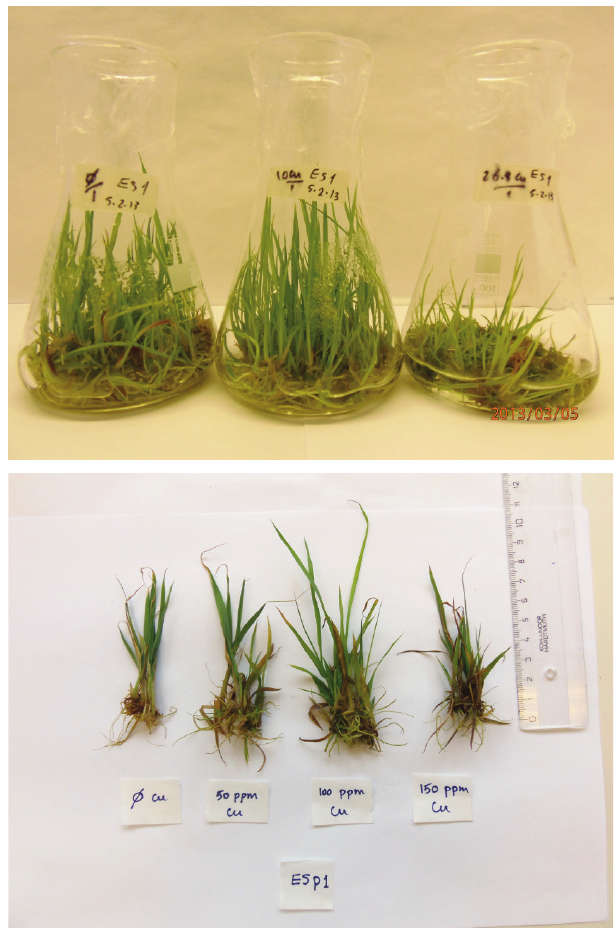
Fig. 1: Giant reed ( Arundo donax L.) tolerant to different concentrations of Cu using liquid media. The Spanish ecotype (ESP 1) was used under different Cu concentartions from 0 to 26.8 mg Cu kg -1 or from 0 to 150 ppm in two different experiments (photos by T.